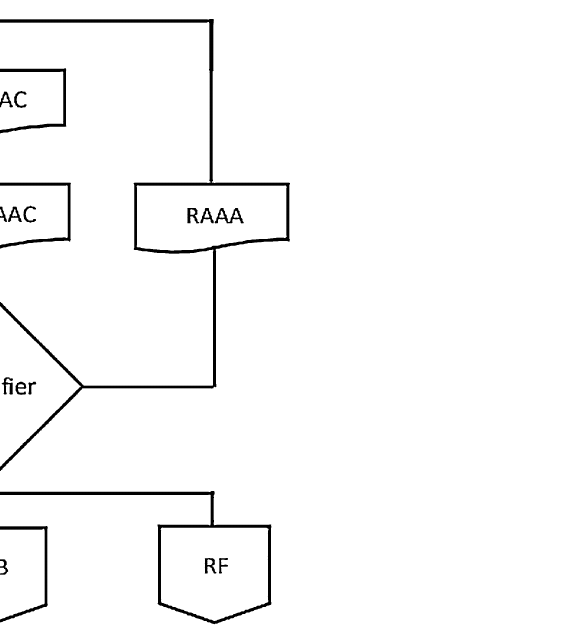
Figure 1. Schematic view of the proposed